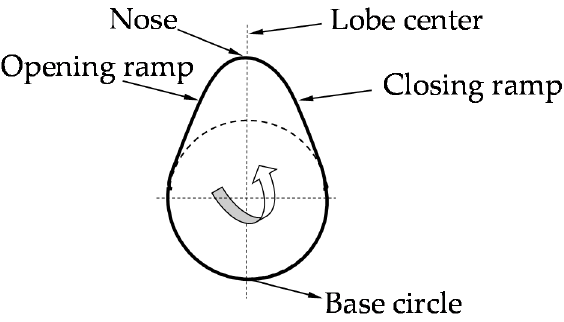
Figure 5. Functional surfaces on the cam.